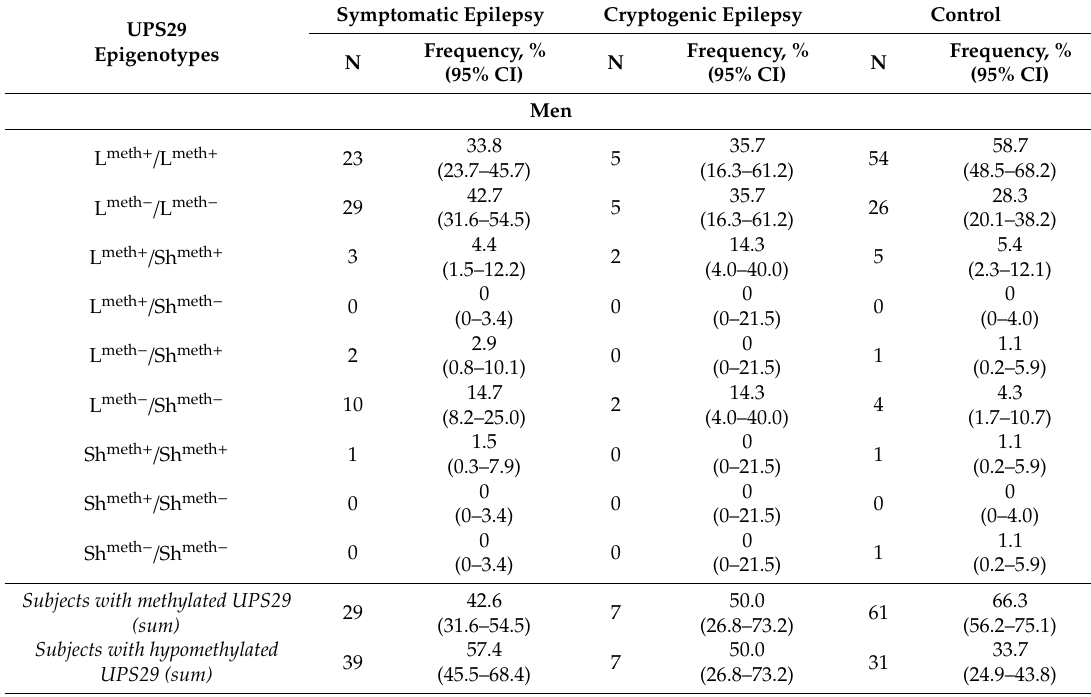
Table 9. The frequency of UPS29 epigenotypes in patients with epilepsy (symptomatic and cryptogenic) compared with the control